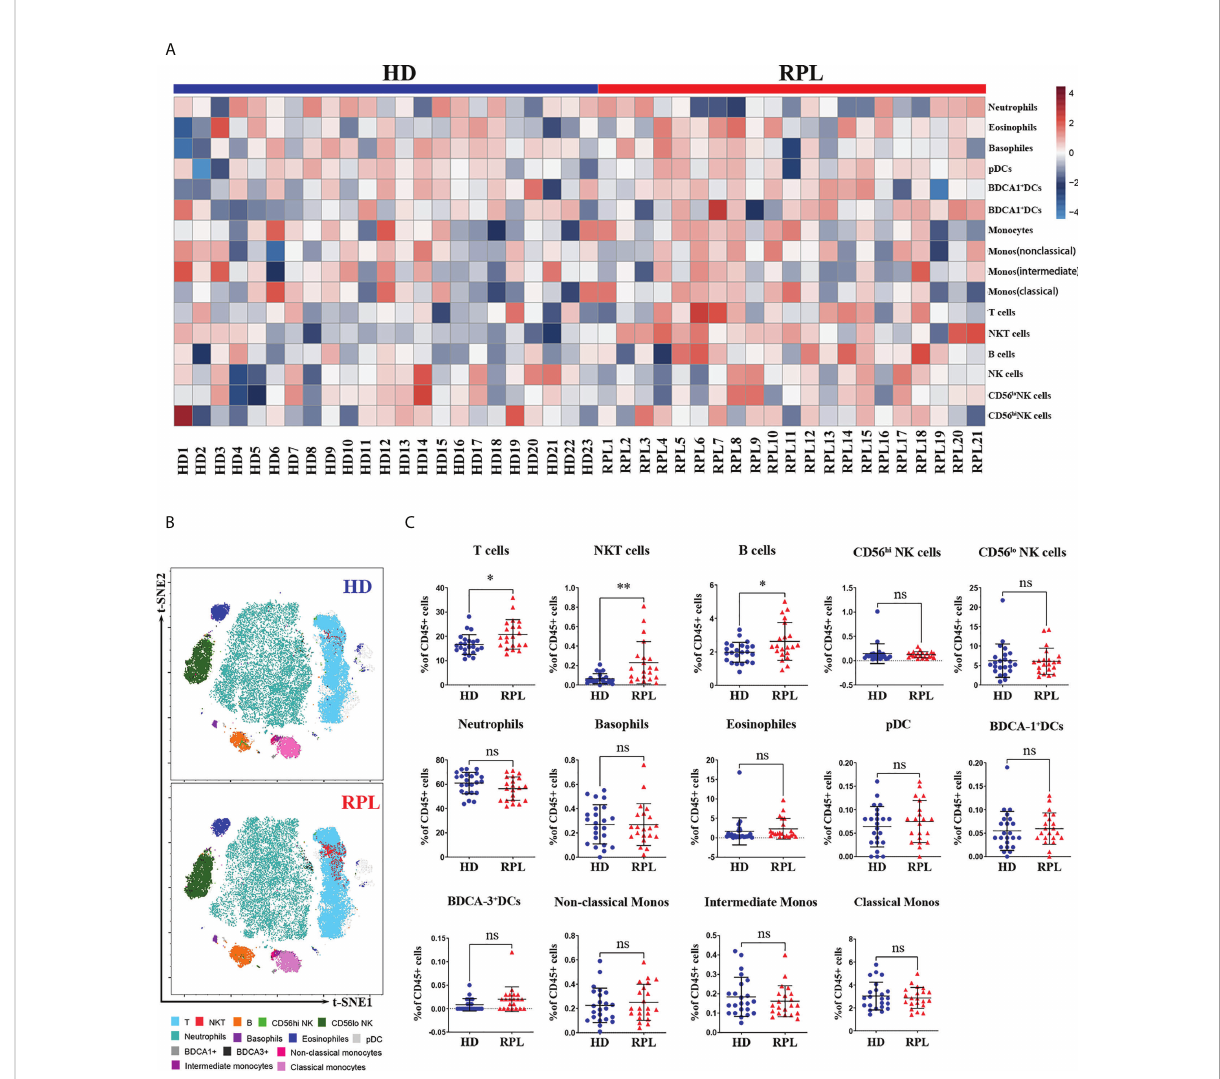
FIGURE 2 Global changes in peripheral immune cell pro fi les. (A) Heatmap representation presenting the patient-to-patient variability of the log odds ratio derived from the percentage of CD45 + cells. (B) Representative tSNE plots of clustered CD45 + peripheral immune cells were shown changes in RPL patients and HDs. (C) Regulated peripheral immune cell populations differentially abundant between RPL patients and HDs identi fi ed by fl ow cytometry. p<0.05 (*), p<0.01 (**) and ns, no signi fi